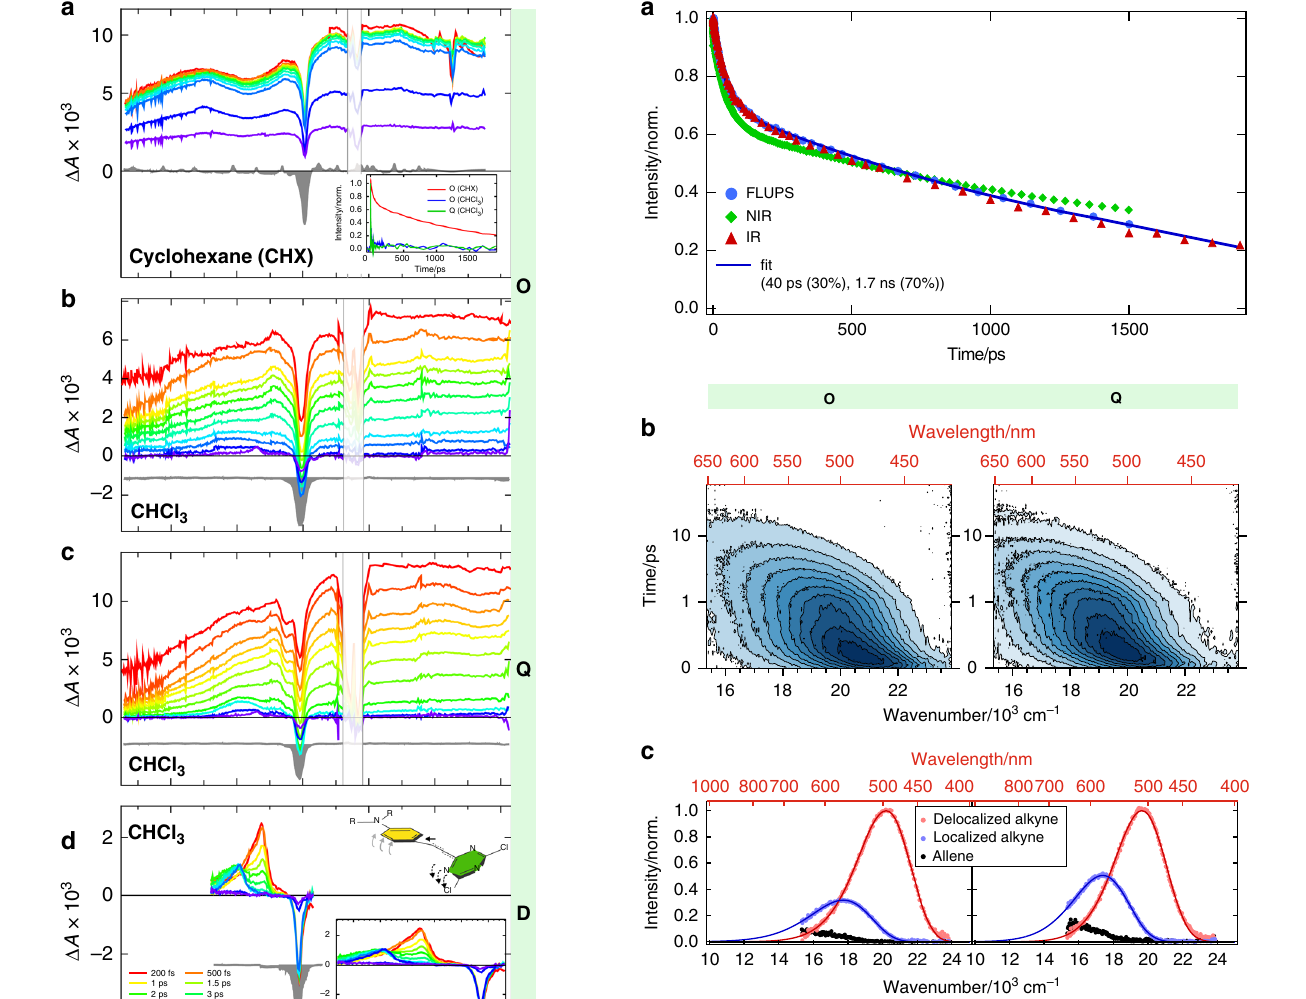
Fig. 3 Delocalized exciton evolution and time-resolved fl uorescence spectroscopy. a Time evolution of the delocalized exciton O in the non- polar cyclohexane as extracted from three different methods: Fluorescence up-conversion spectroscopy (FLUPS) emission (blue circles), IR excitonic S 2 ← S 1 transition (red triangles) and higher-energy NIR transition (peaking at 863 nm, green diamonds). The solid line is a biexponential fi t to the FLUPS data shown with the time constants and their respective amplitudes. b FLUPS contour plots obtained for O and Q in the highly polar benzonitrile. The equidistant blue-shaded contours are drawn every 10% from zero (white) to the maximum intensity (dark blue). The time axis is linear between 0 and 1 ps and logarithmic afterwards. c Results of a global analysis of the FLUPS data according to a consecutive A → B → C → scheme representing the emission of three distinct species/states: delocalized unrelaxed exciton (red), localized exciton (blue) and allene photoproduct (black). Circles represent experimental data points, solid lines are lognormal fi ts. The fl uorescence intensity of the localized exciton is 1/3 and 1/2 of the delocalized one for O and Q